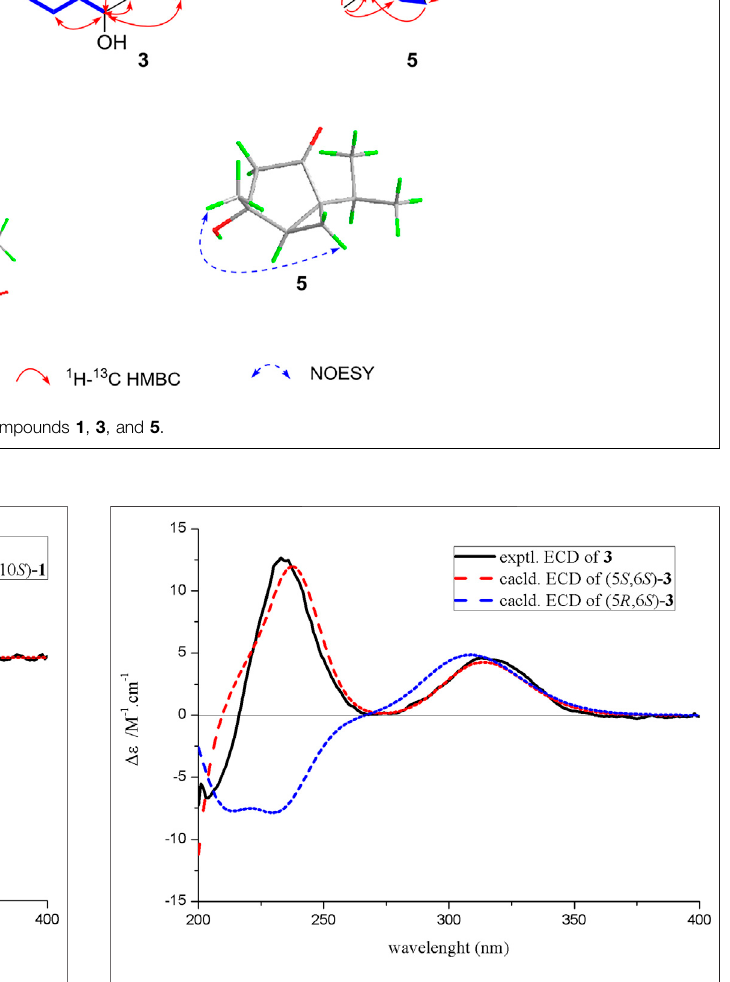
FIGURE 3 | Experimental and calculated ECD spectra of compound 1 . FIGURE 4 | Experimental and calculated ECD spectra of compound 3